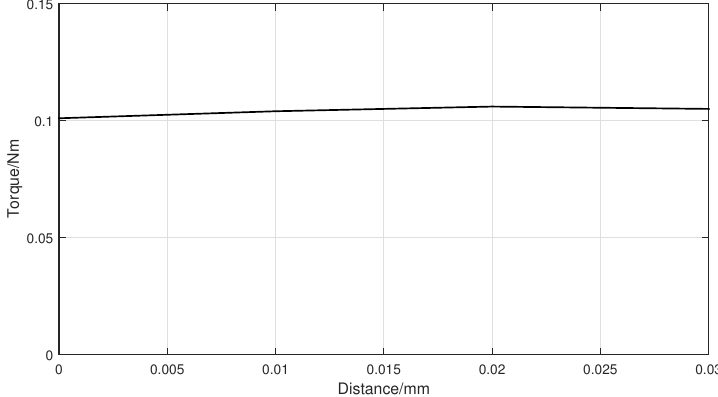
Figure 11. Influence of displacement assembly error along Z axis on torque